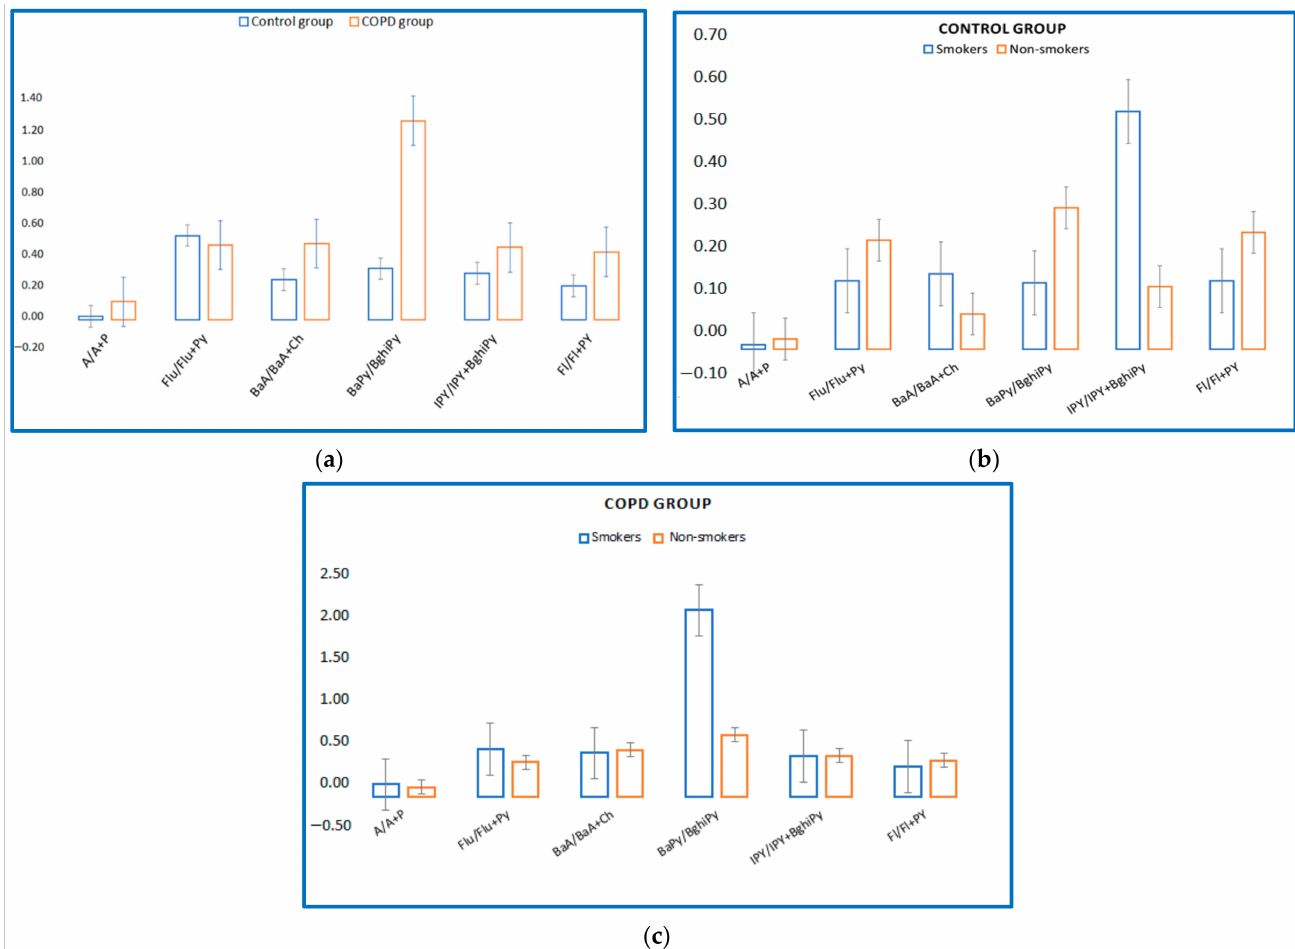
Figure 3. ( a ) Levels of molecular PAHs in blood serum of COPD/control group. ( b ) Levels of molecular PAHs in blood serum of control group, smokers/non-smokers. ( c ) Levels of molecular PAHs in blood serum of COPD